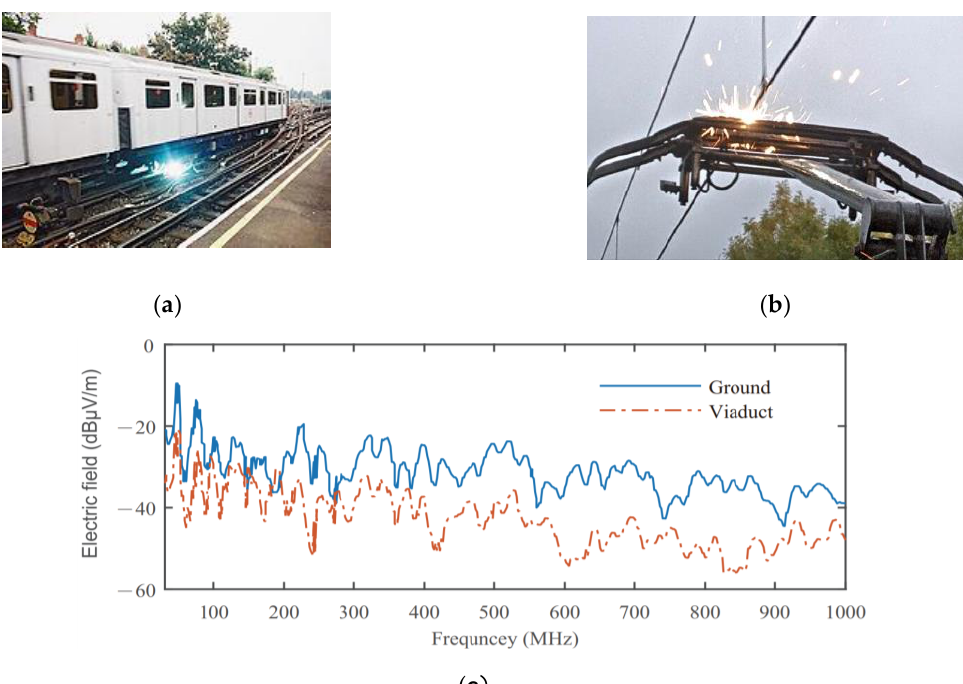
Figure 25. Arcing phenomenon and measured radiated emission in ERPS. ( a ) Pantograph arcing. ( b ) Brush arcing. ( c ) The measured electric field emission in the range frequency of 30 MHz to 1 GHz with train positions on ground and viaduct [145].